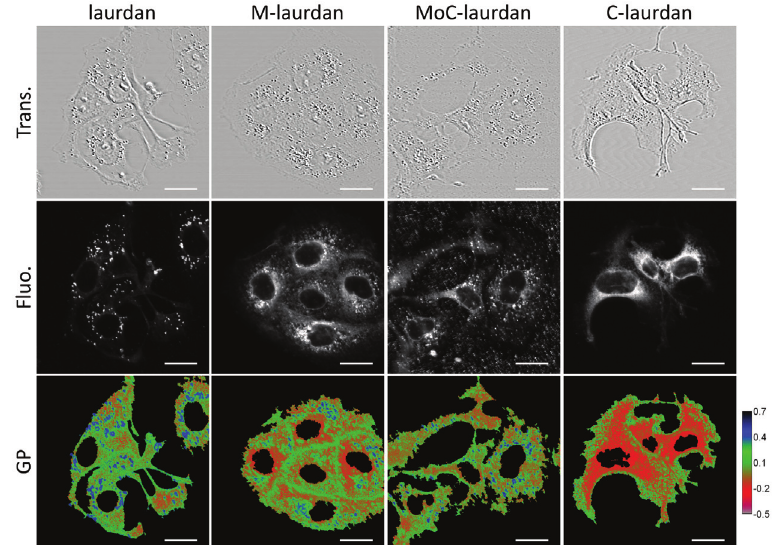
Figure 8. Two-photon imaging of COS7 cells labelled with the four different probes. Upper row: transmission (Trans.); middle row: total fluorescence (Fluo.) from 420 to 600 nm; bottom row: GP calculated with the values from 10 nm channels centered on 440 and 490 nm (scale bar, 20